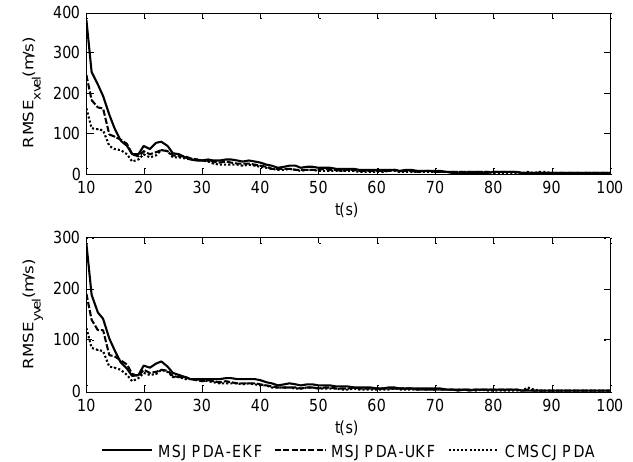
Figure 4. Root mean square velocity error of target 1.